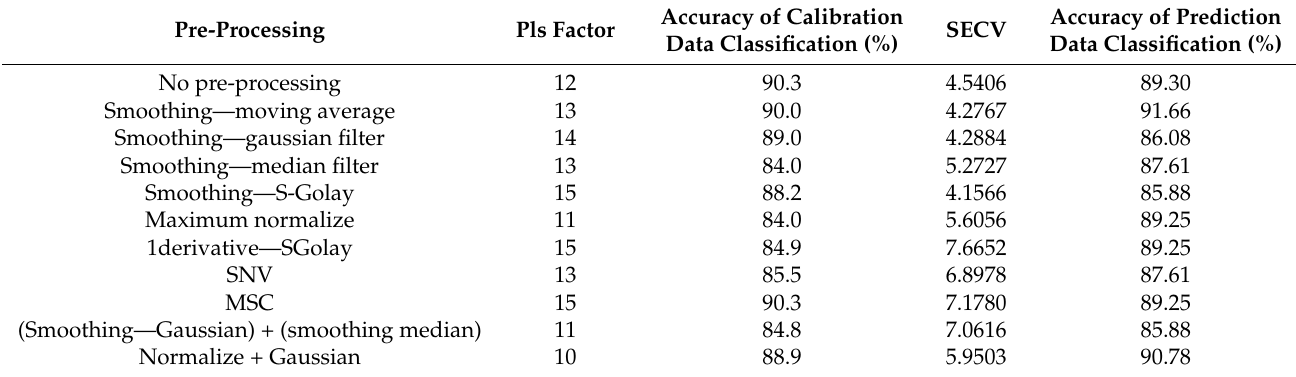
Table 6. Results of partial least squares discriminant analysis (PLS-DA) analysis obtained for different pre-processing methods.